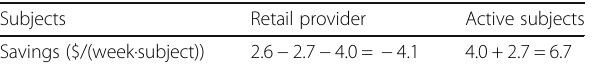
Table 3 Financial benefit of the retail provider and